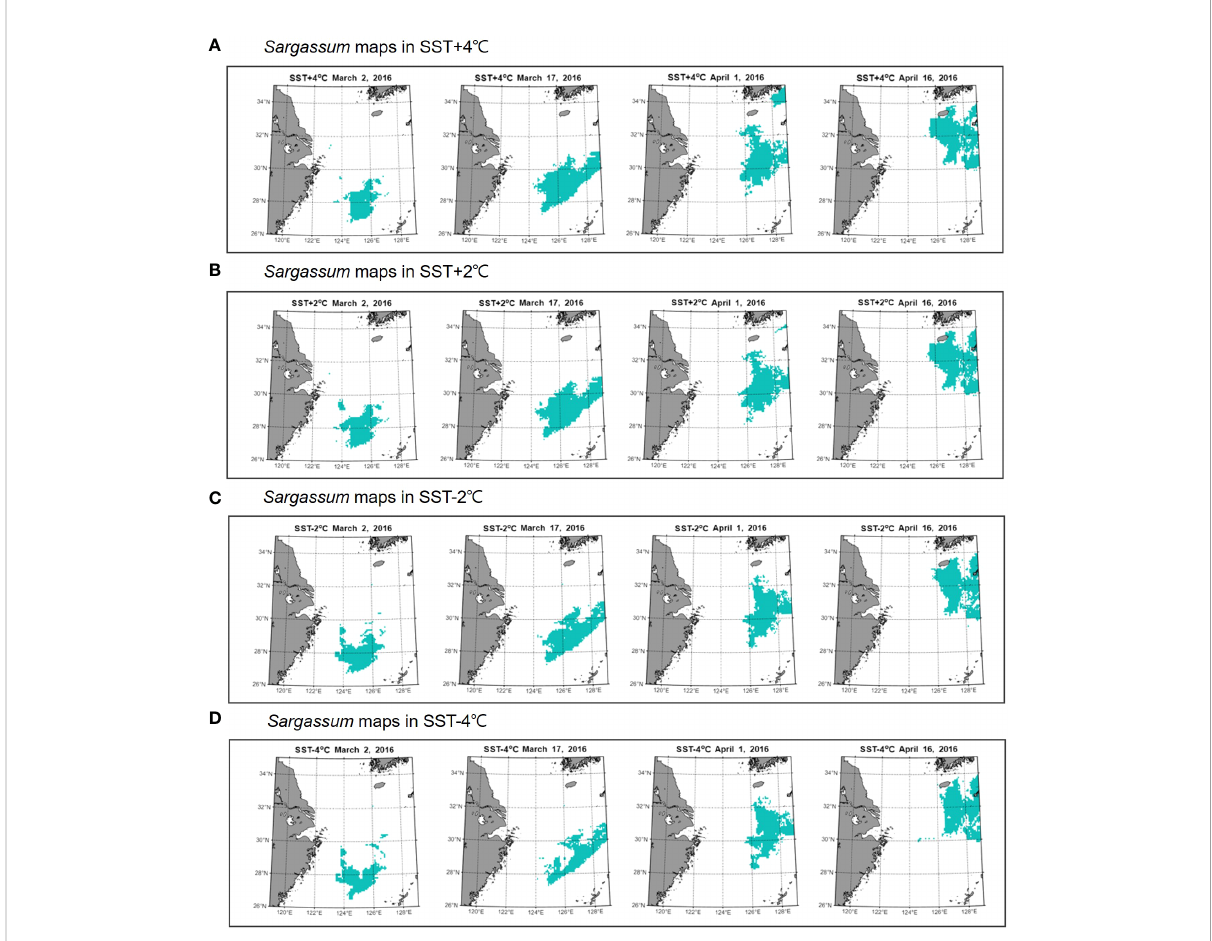
FIGURE 6 Sargassum maps according to changing SST in 2016 every 15 days. From the top to the bottom, the maps showed the results after applying four options: (A) SST + 4 °C, (B) SST + 2 °C, (C) SST − 2 °C, and (D) SST − 4 °C. The original case is represented in Figure